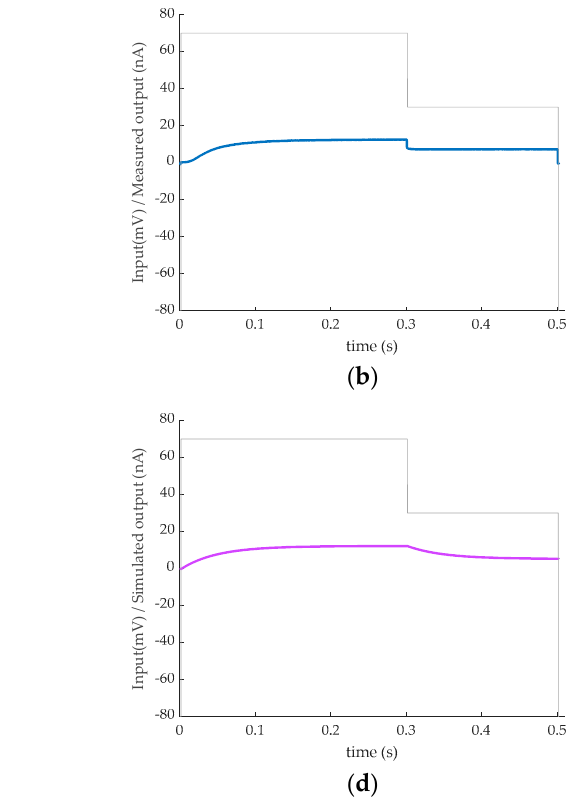
( b ) Figure 9. Simulink Kv10.1 model in a control loop ( a ); simulated output for sine input ( b ). Microelectromechanical (MEMS) devices and nanoelectromechanical (NEMS) de- vices can be designed as MEMS PID controllers and NEMS PID controllers. In a clinical context, nanorobots are already used for the mechanical opening of a cell membrane [32]3, microscopic surgical procedures, drug delivery, gene therapy, or selective destruction of cancer cells [4]. Therefore, our vision is that free-floating and guided nanorobots could have promising applications in cancer detection and therapy. Research has shown that the up-regulation of the selected channel Kv10.1 can promote cell proliferation and thus tu- mor development in different organs and human body systems [18], whereas the down- regulation of Kv10.1 could potentially have the opposite effect, providing a potential on- cological target. However, since the same ion channels are also expressed in normal, healthy cells, albeit to minor expression levels, one of the biggest challenges is to specifi- cally block or manipulate them only in cancer cells. Nanorobots could be programmed to target certain cell clusters, tissues or organs (e.g., prostate, stomach, or breast) and specif- ically control the activity of selected ion channels in cancer cells without affecting the same channels expressed in surrounding healthy cells or other tissues and thus impairing their function. A controlled down-regulation of the ion channel current in specific cells only would also allow for a systemic application, such as the use of traveling nanorobots for 0